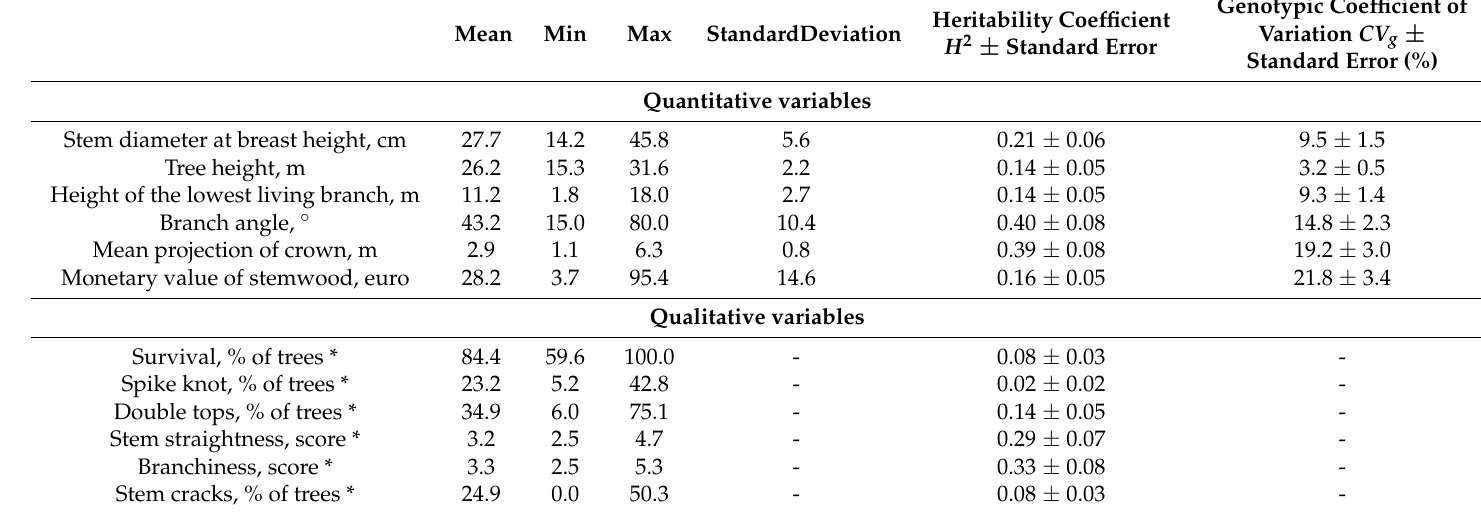
Table 1. Statistics, coefficients of heritability ( H 2 ), and genotypic variation ( CVg , %) of the morphometric variables (traits), and monetary value of 40-year-old grafted birch plus-trees from the low-density plantation. The monetary value of stemwood was calculated considering stem quality.